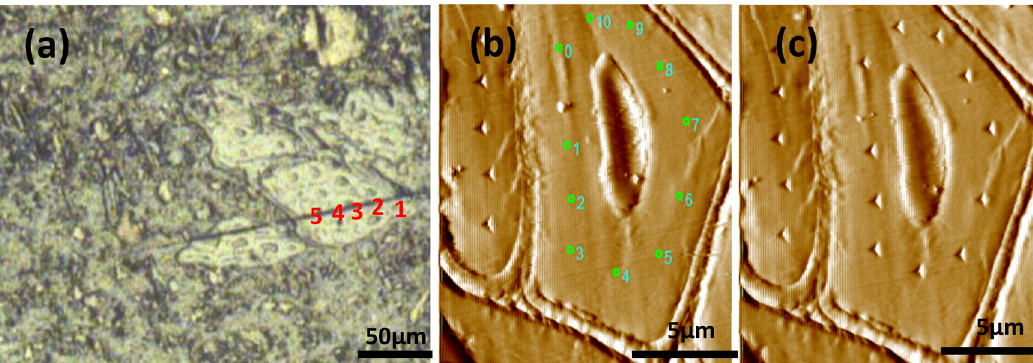
Figure 2: Typical in situ imaging nanoindentation test: ( a ) microscope image of testing cells in transverse section, ( b ) image of cell walls in region 1 of ( a ) before indenting, and ( c ) image of cell walls in region 1 of ( a ) after